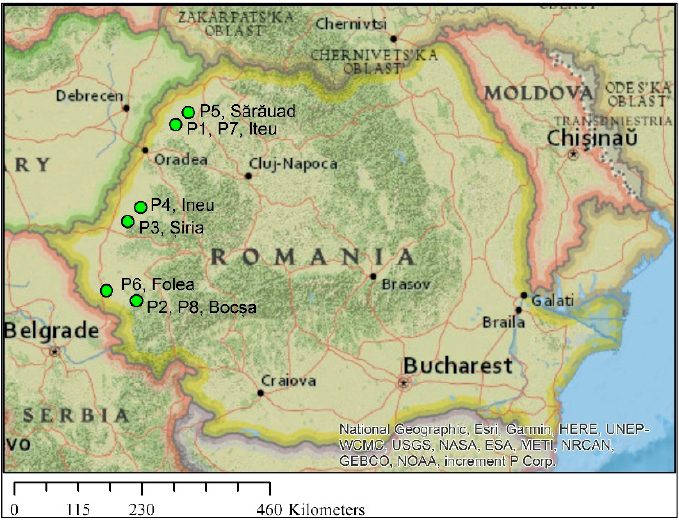
Figure 12. The geographic origin of the propolis samples (green dots).